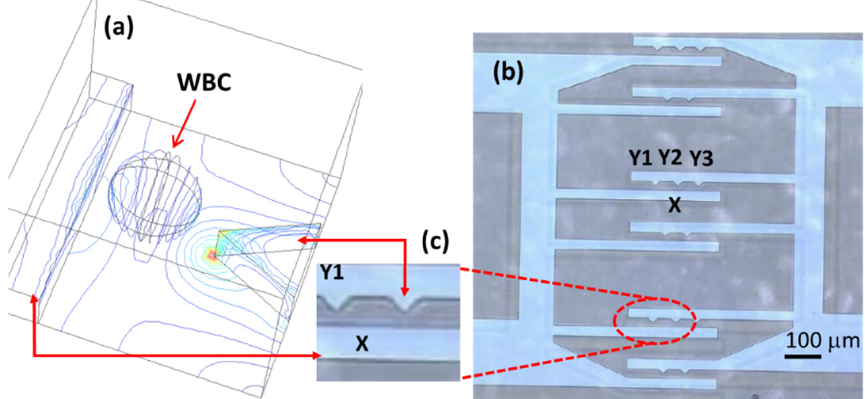
Figure 1. ( a ) 3D numerical simulation of electrodes and cell (electrode height not to scale) showing electrical potential lines in a representative medium. ( b ) Optical microscope image of ITO electrodes on glass, with electrodes labeled (X, Y1, Y2, Y3). ( c ) Closeup of a fraction of electrode array at the region of highest field strength. Cells are attracted to this region by DEP forces and fixed at electrode tips, where they are subsequently deformed.